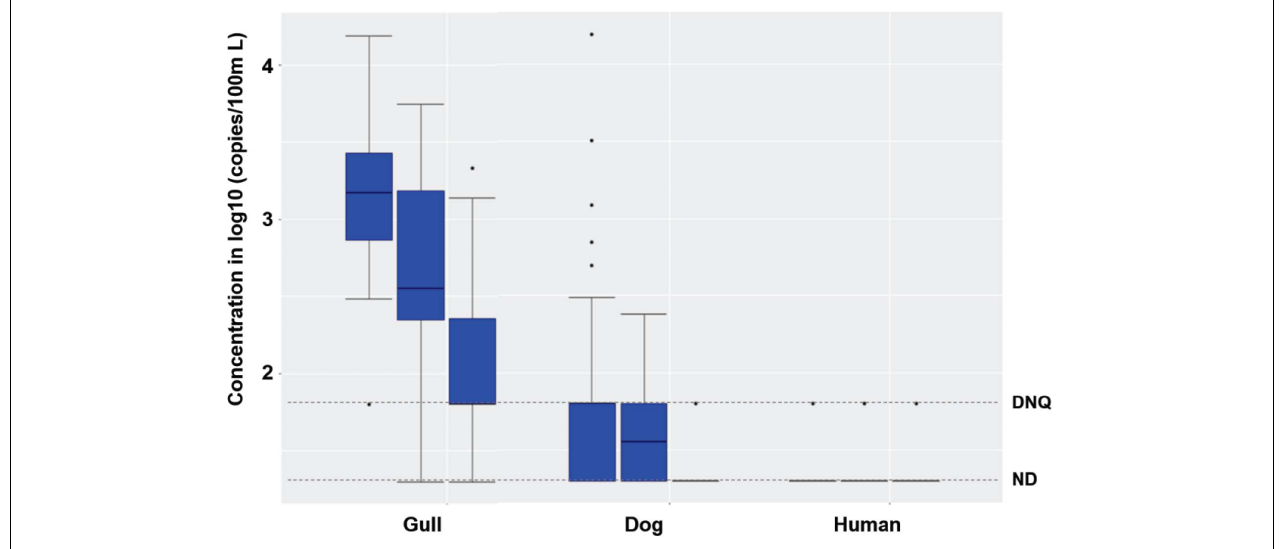
FIGURE 3 | Boxplots of gull, dog and HF183 human fecal marker concentrations in surf zone, nearshore, and offshore (from left to right in each box set, one set per marker) water samples in 2016 and 2017. The number of surf zone, nearshore, and offshore samples was 40, 24, and 32, respectively. DNQ (1.8 on log10 scale) and ND (1.3 on log10 scale) levels were shown in the figure as dotted